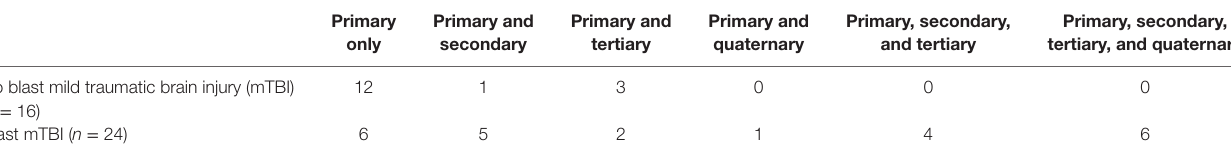
TaBle 3 | Blast exposure subgroups.